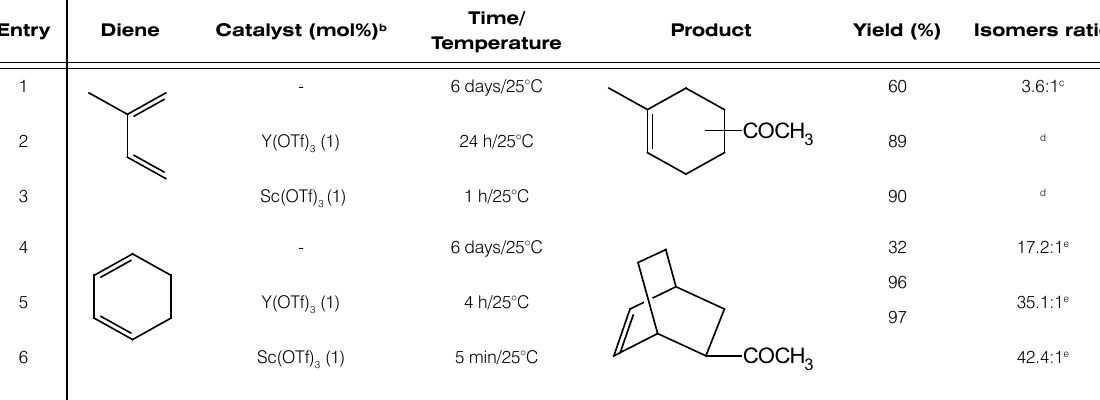
Table 5. Yield and selectivity of the Diels-Alder reaction between 2-methyl-1,3-butadiene or 1,3-cyclohexadiene and 2c in deanol based IL a